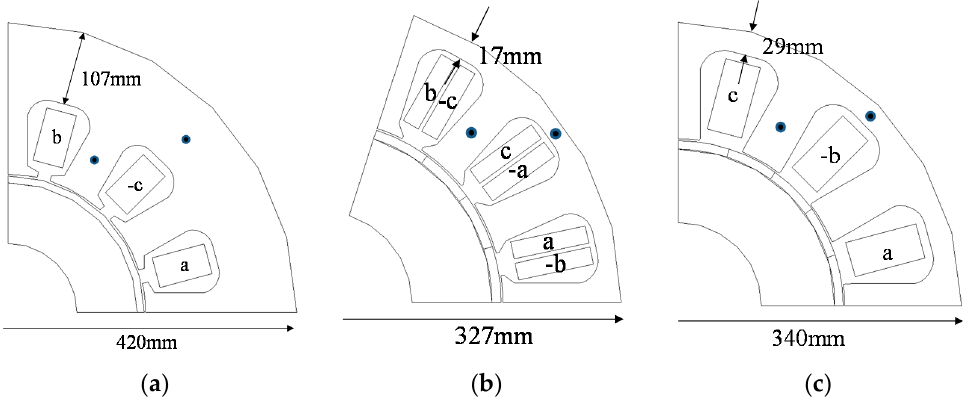
Figure 3. A vernier and two conventional motors designed for comparison. ( a ) FW conv. (12 slots/4 PM); ( b ) CW conv. (18 slots/20 PM); ( c ) FW vernier (12 slots/20 PM). (Dots: the positions for calculation of flux density).